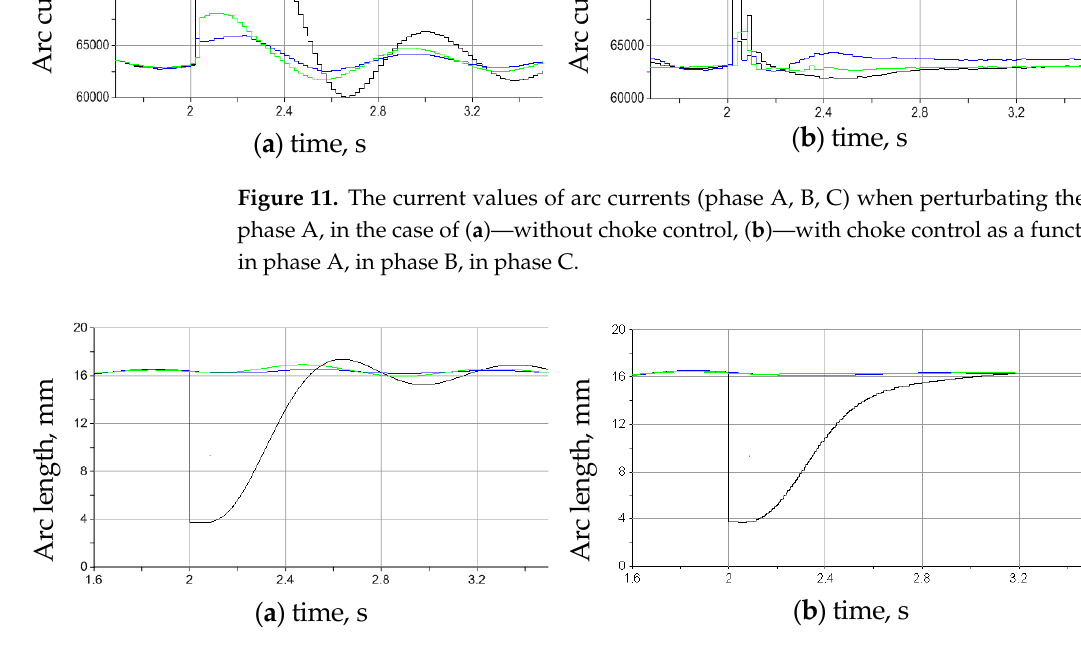
( b ) time, s Figure 13. Arc length in phases B, C when perturbating the arc length in phase A, incases ( a )— without choke control, ( b )—with choke control as a function of current: in phase B, in phase C. To ensure maximum power in the arc, it is necessary to stabilize the specified ratio between voltage and arc current (arc impedance), determined from (18). With this in mind, combined choke control is proposed. In this control, in the area of significant discrepancies Δ arc (at the beginning of the perturbation, with a significant change in the power of the arc), control of the inductor is carried out as a function of mismatch, and in the area of small deviations—as a function of current. In Figure 14 are shown the change in the Δ arc mismatch when using choke current control and combined control. Table 2 provides the standard deviation for the Δ arc mismatch when using different choke control methods. The results show that from the point of view of minimizing the standard devia- tion Δ arc, the combined law of choke control provides better results in comparison with the classical control of arc currents, although the current asymmetry is greater. Δ a r c ( a ) time, s Δ a r c ( b ) time, s Figure 14. Mismatch Δ arc when perturbating the arc length in phase A, in cases ( a ) with choke control as a function of current ( b ) with combined control of choke: in phase A, in phase B, in phase C.